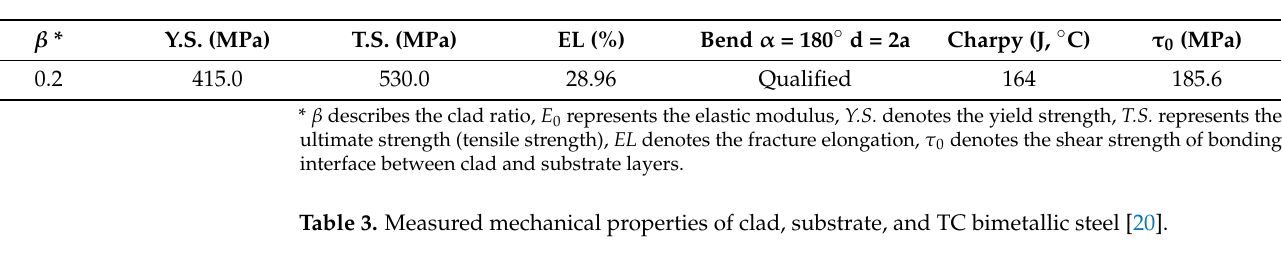
Table 2. Mechanical properties provided by certificate warranty.